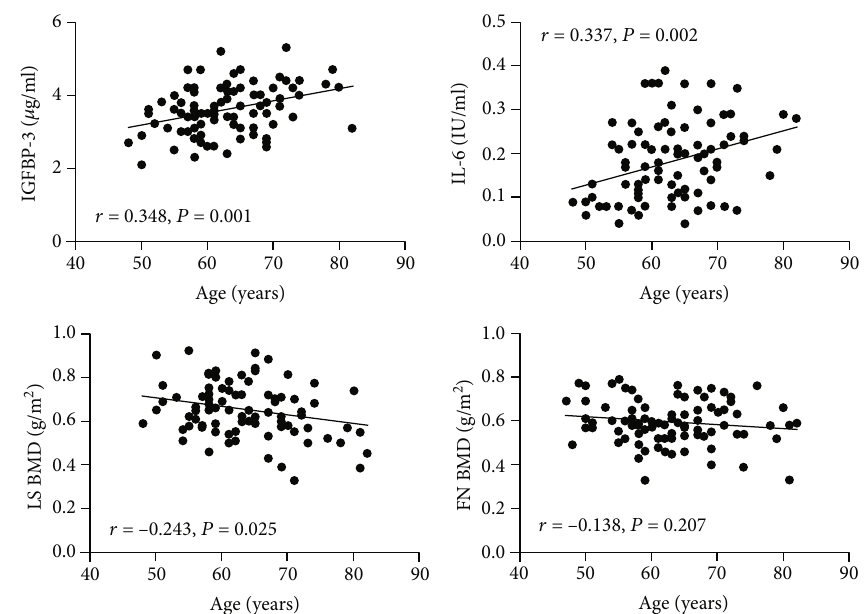
Figure 1: Correlations of age with IGFBP-3, IL-6, and BMD at the lumbar spine and femoral neck in all postmenopausal women. LS: lumbar spine; FN: femoral neck.